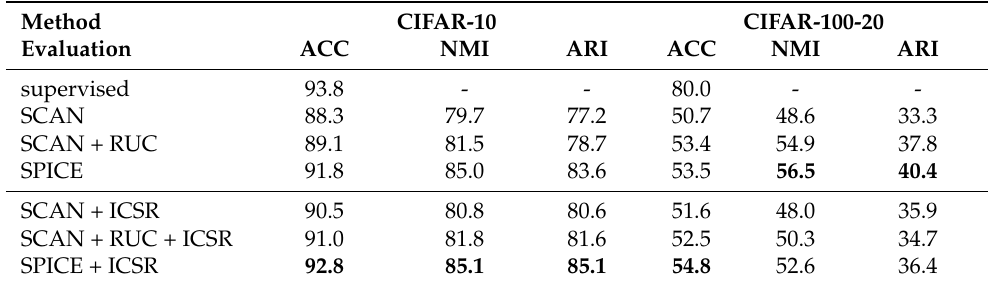
Table 3. Unsupervised image classification on CIFAR-10. The model is trained on the training images without using their labels (unsupervised) and classification accuracy evaluated on the testing images. The best results are highlighted by the bold.